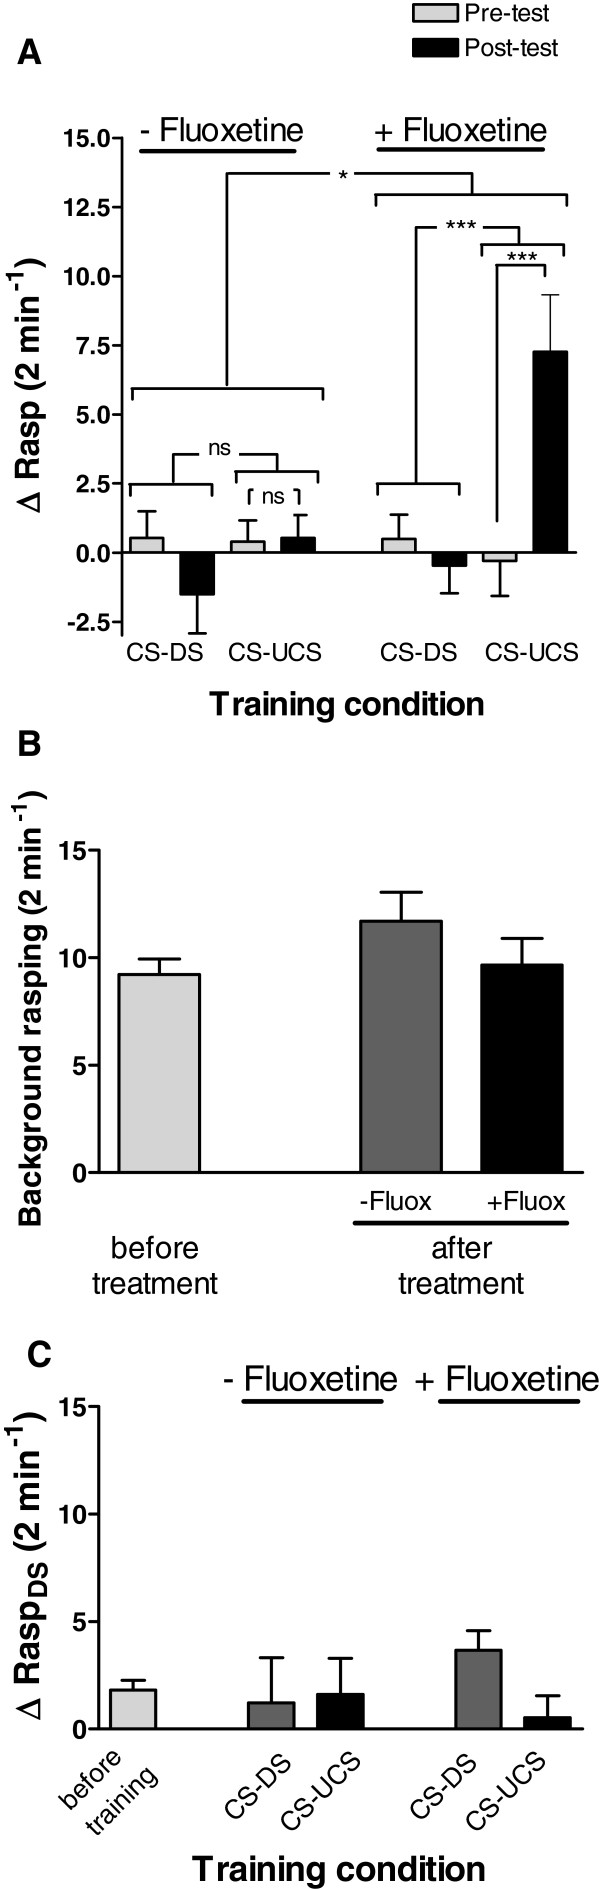
Effect of fluoxetine treatment on LTM performance in senior animals. A. Long-term memory assessment of senior snails following treatment with fluoxetine (+ Fluoxetine) or vehicle only (− Fluoxetine). Fluoxetine treatment significantly improved LTM performance in conditioned (CS-UCS) senior snails. In contrast, vehicle only treated conditioned animals showed no indication of LTM. B. Comparison of spontaneous background rasping rates reveals no significant differences between animals treated with fluoxetine (+ Fluox) or vehicle only (−Fluox). C. Comparison of rasping response after application of the disturbance stimulus reveals no significant differences between unconditioned (CS-DS) and conditioned (CS-UCS) animals regardless whether they were treated with fluoxetine (+ Fluox) or vehicle only (−Fluox). * = p < 0.05, *** = p < 0.001, ns = non-significant.